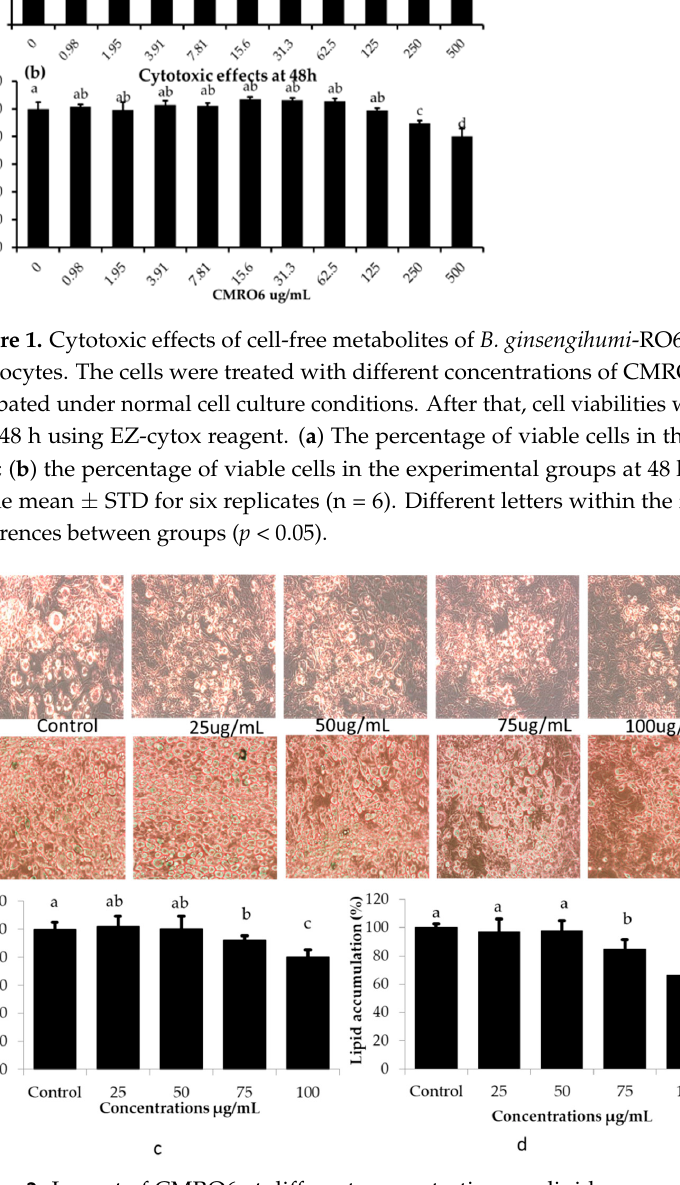
Figure 2. Impact of CMRO6 at different concentrations on lipid accumulation and differentiation. Cells were seeded in cell culture plates and incubated at 37 °C with 5% CO 2 . The differentiation was induced by dexamethasone, IBMX, and insulin for 48 h and then media was replaced by insulin medium for another 48 h. CMRO6 at different concentrations was added to the cell when differentiation began. Differentiated cells were then monitored under an Evos microscope and lipid deposits were stained with Oil Red O stain. The differentiated cells were photographed on the 5th and 10th day of differentiation. The stained lipids were extracted using isopropyl alcohol and lipid levels were measured. ( a , b ) Microscopic views of lipid accumulation in differentiated cells at 5th and 10th day of differentiation; ( c , d ) the percentage of lipids in experimental adipocytes at 5th and 10th day of differentiation. The data are represented as the mean ± STD of six replicates (n = 6). Different letters within the figure indicate significant differences between groups ( p < 0.05).